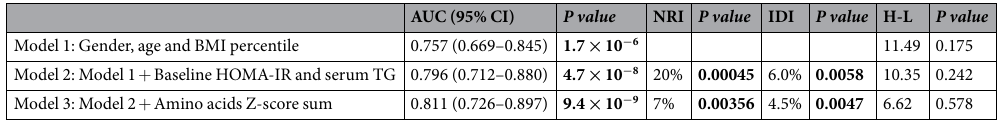
Table 3. Comparison of models for prediction of development of hypertrigliceridemia over 2 years in children with normal TG levels at baseline. H-L: Hosmer-Lemeshow χ 2 statistics, NRI: net reclassification improvement, IDI: integrated discrimination